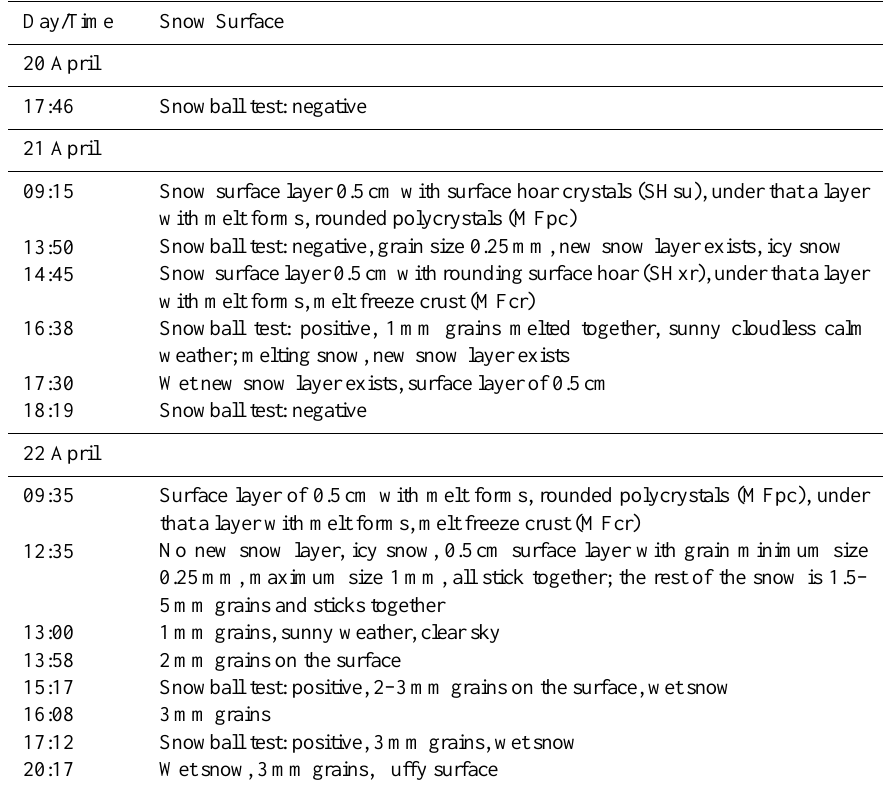
Table 2. Snow conditions during the time [UTC] of the spectral albedo measurements. The snow grain shapes are according to Fierz et al.